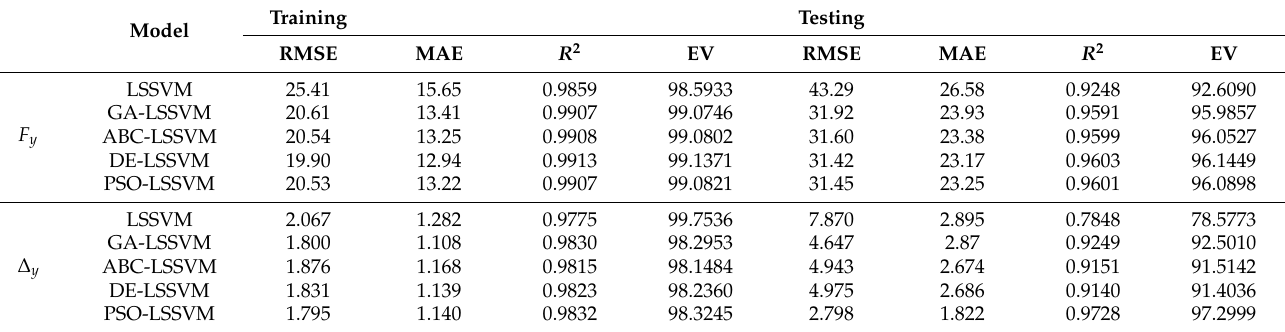
Table 5. Evaluation results of standard LSSVM, GA-LSSVM, ABC-LSSVM, DE-LSSVM,